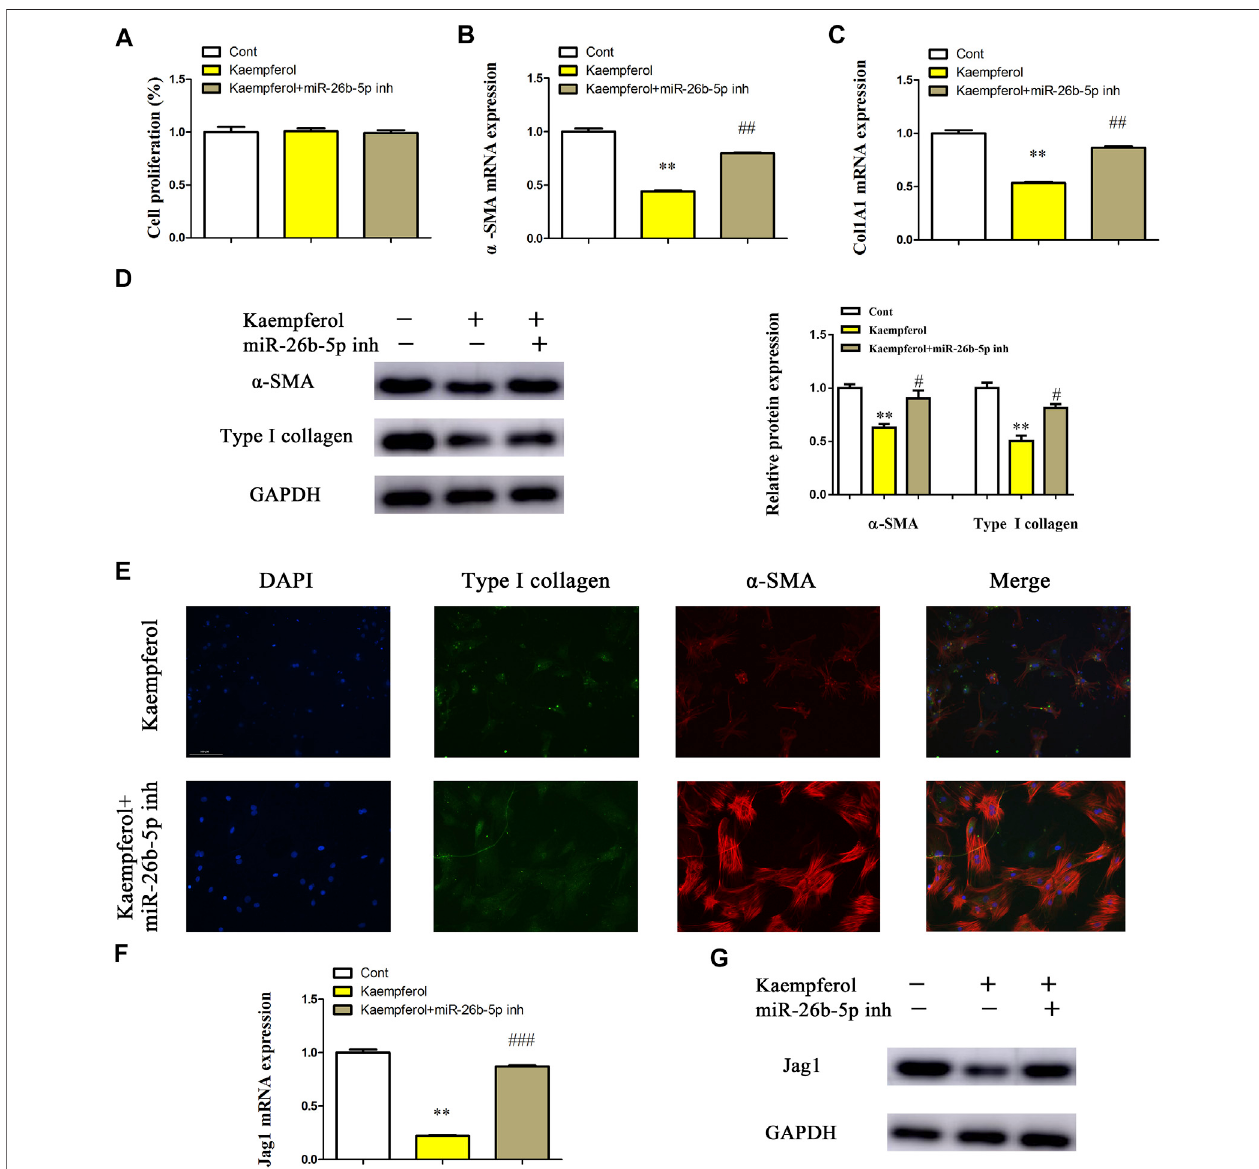
FIGURE 6 | Kaempferol suppresses HSC activation through miR-26b-5p-mediated Jag1 axis. Primary 1-day-old HSCs were treated with 10 μ M kaempferol for 24 h and then transfected with 100 nM miR-26b-5p inhibitor for additional 24 h. (A) Cell proliferation. (B) α -SMA mRNA level. (C) Col1A1 mRNA level. (D) Protein expressionsof α -SMAandTypeIcollageninkaempferol-treatedHSCsaftermiR-26b-5pinhibitortreatment. (E) Immuno fl uorescencestainingfor α -SMA(red)andtypeI collagen (green). DAPI stained nuclei blue. (F,G) Jag1 mRNA and protein were detected in kaempferol-treated HSCs after miR-26b-5p inhibitor treatment. Three experiments with similar outcome. ** p < 0.01 compared with the control, and # p < 0.05, ## p < 0.01, ### p < 0.001 compared with kaempferol group.